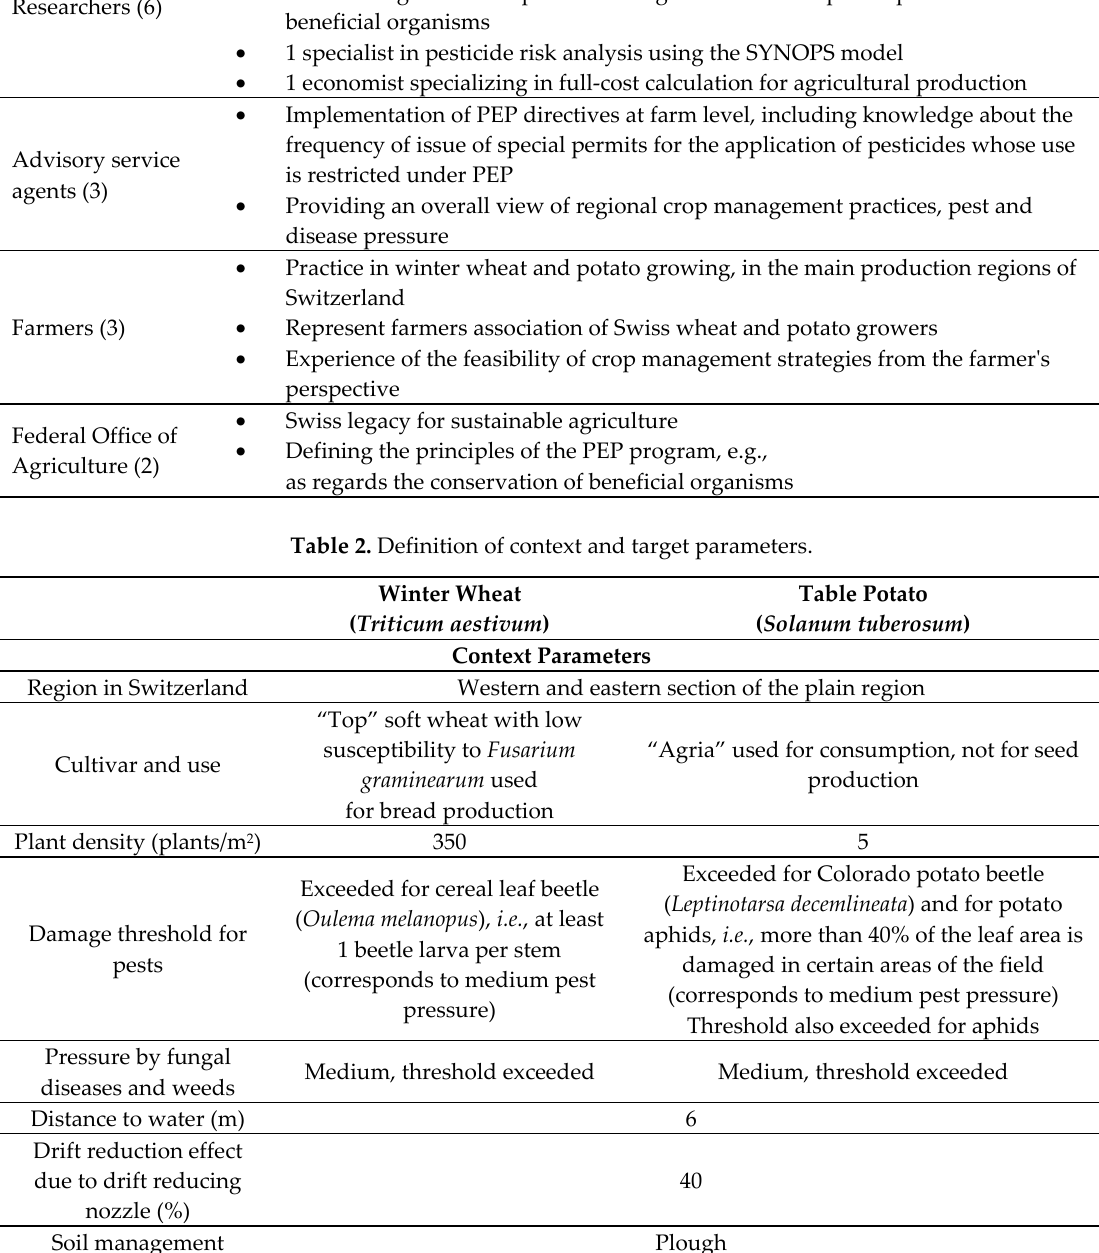
Table 1. Competences represented by the expert group.